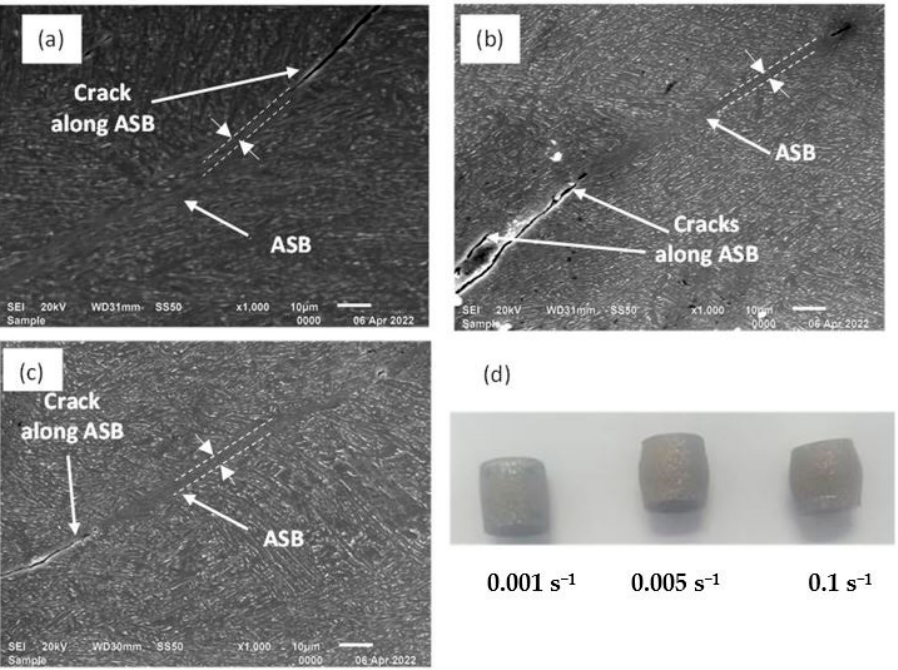
Figure 14. Typical shear-deformed surfaces of samples C after tests at strain rates of ( a ) 0.001 s − 1 , ( b ) 0.005 s − 1 and ( c ) 0.1 s − 1 , while ( d ) shows the typical condition of the test samples after testing at the respective strain rates.